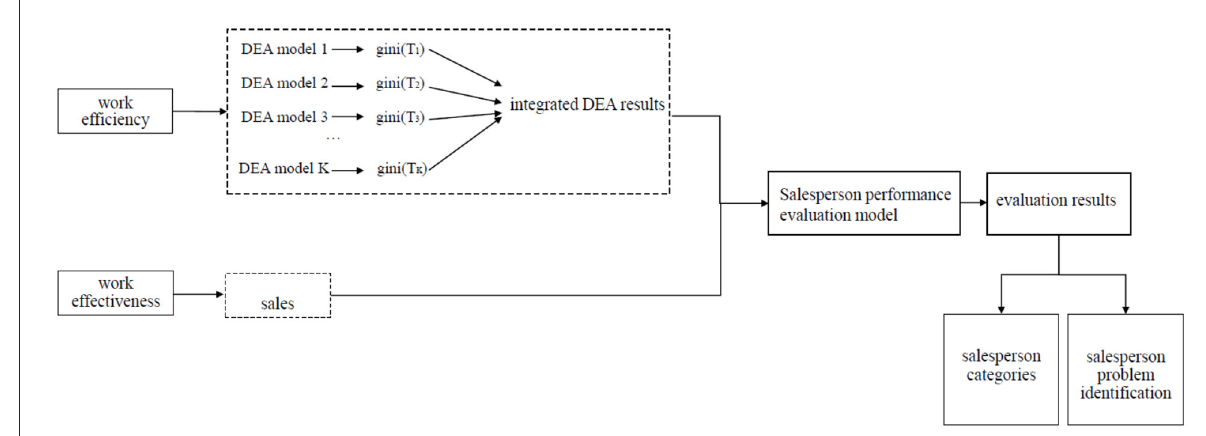
FIGURE1 Salesperson performance evaluation framework and logic.